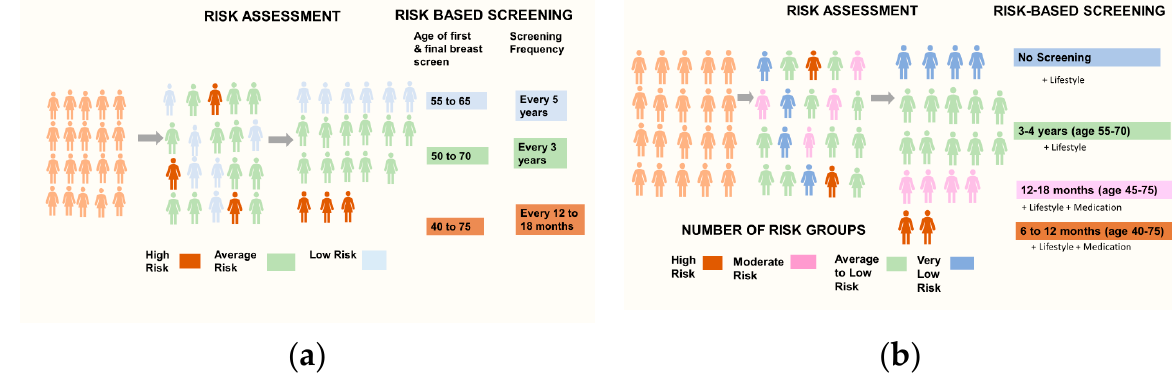
Figure 1. Schematic outline of PRA and RSBS as presented during the interviews. ( a ) Age-range of screening eligibility and screening frequency with three risk groups; ( b ) Age-range of screening eligibility and screening frequency with four risk groups and risk-management options.